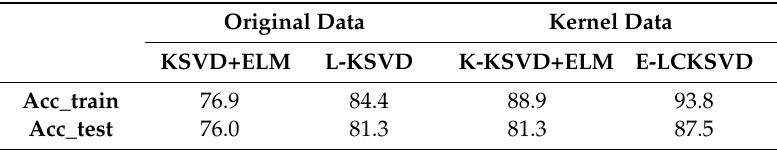
Table 5. The classification accuracy of different KSVD techniques (%).